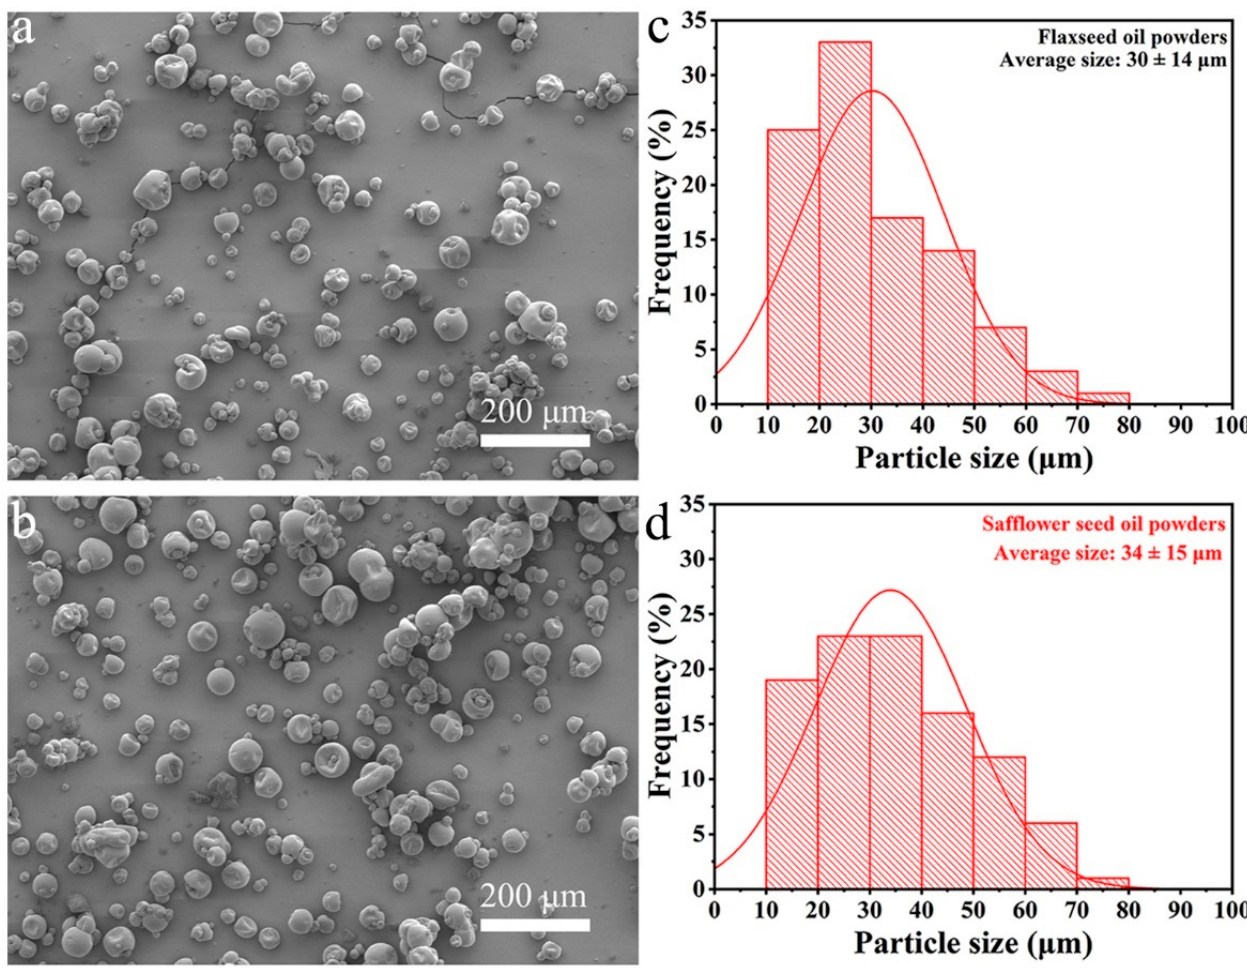
Figure 3. SEM images and corresponding particle size distributions of flaxseed oil powders ( a , c ) and safflower seed oil powders ( b , d ). safflower seed oil powders ( b , d